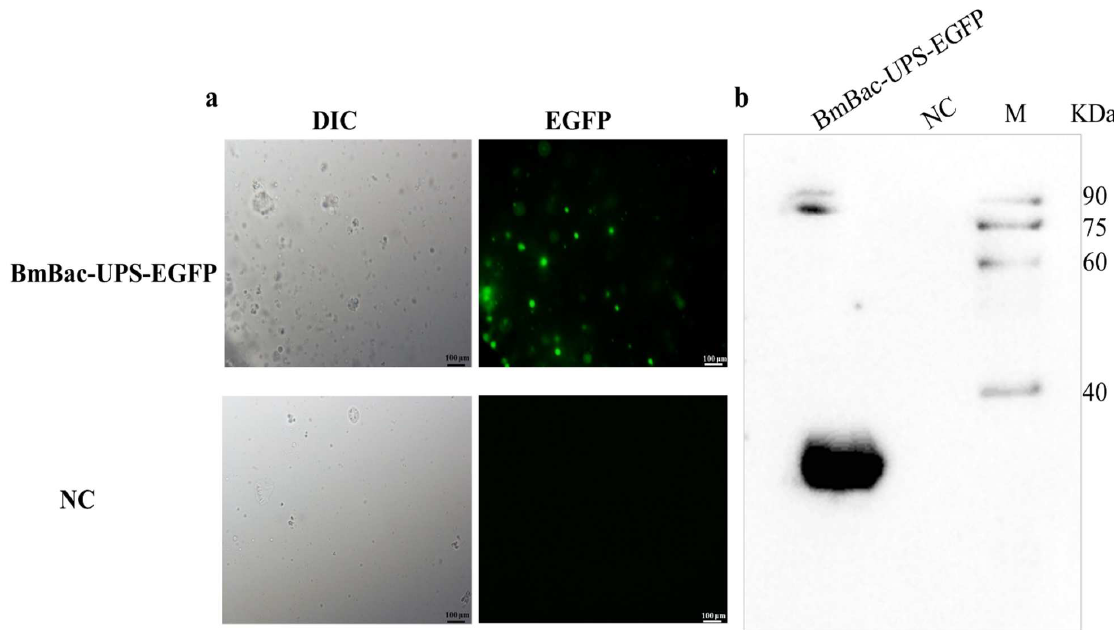
Figure 4. Infection test of the silkworm larvae with the occlusion bodies. ( a ) The blood of virus- infected larvae (BmBac-UPS-EGFP) and uninfected larvae (NC) was visualized by microscopy under visible bright light (DIC) and fluorescence (EGFP). The scale bars in the visible images are 100 µ m. ( b ) Specificity of the HK antiserum. Proteins extracted from infected silkworm (BmBac-UPS-EGFP) and uninfected silkworm (NC) were subjected to Western blot using a polyclonal antibody against EGFP. M, Protein maker (Transgene, Shanghai,